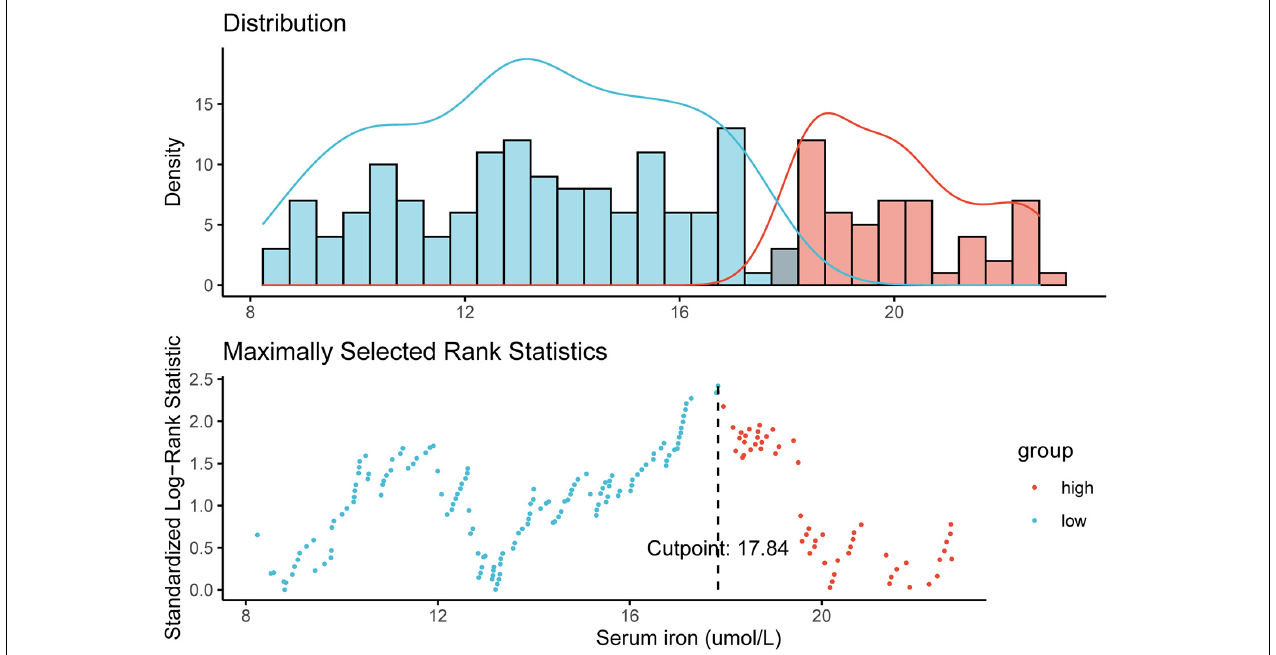
FIGURE 1 | Definition of the cutoff of 17.84 µ mol/L for the serum iron level according to maximally selected log-rank statistics.